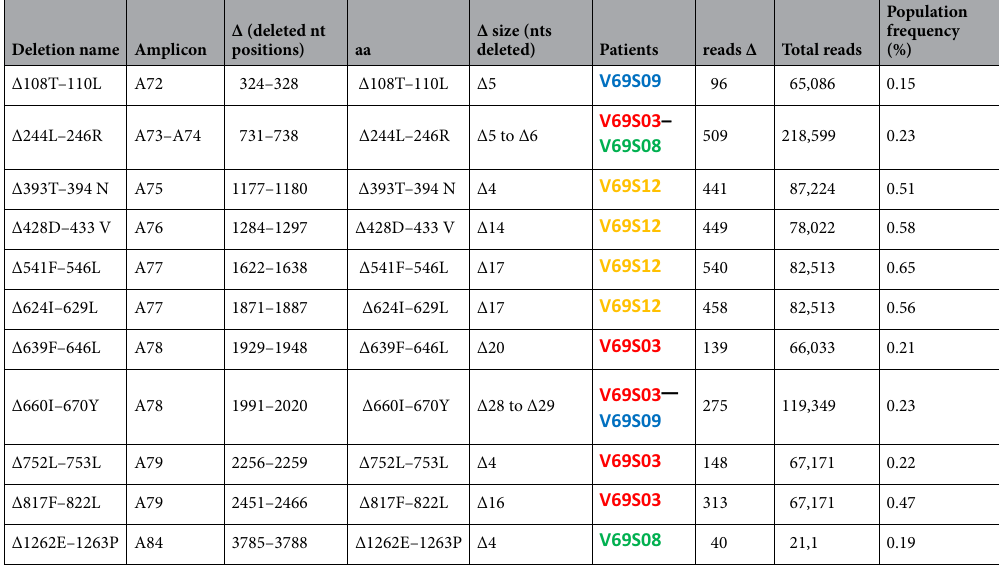
Table 2. Variant B.1.1.